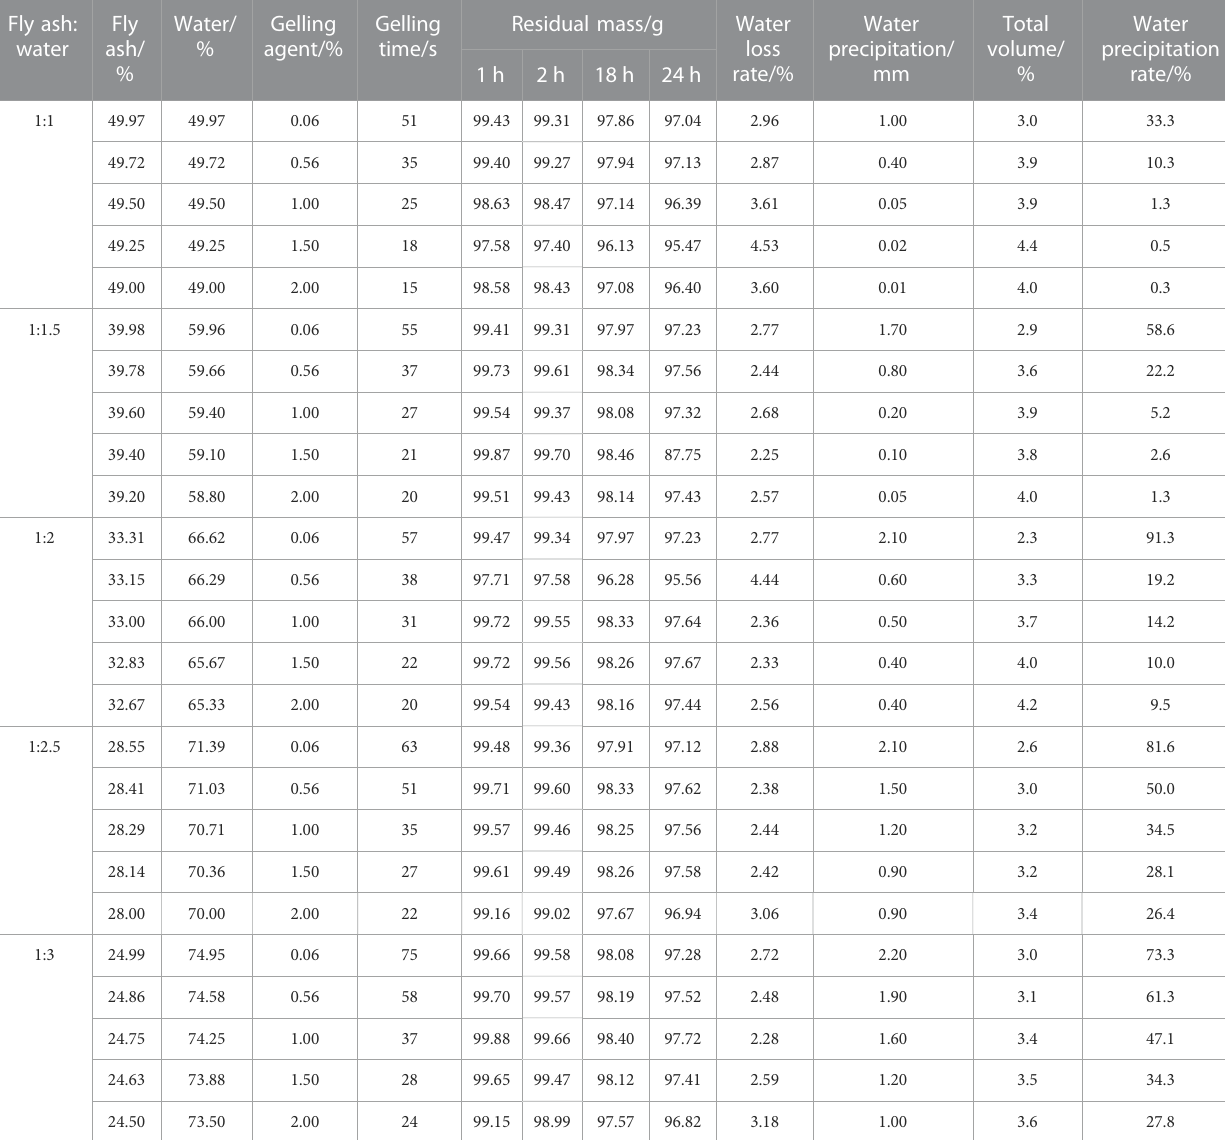
TABLE 4 Calculation results of the water loss rate and water precipitation rate of the fl y ash colloid fi re extinguishing agent. Fly ash: Fly water